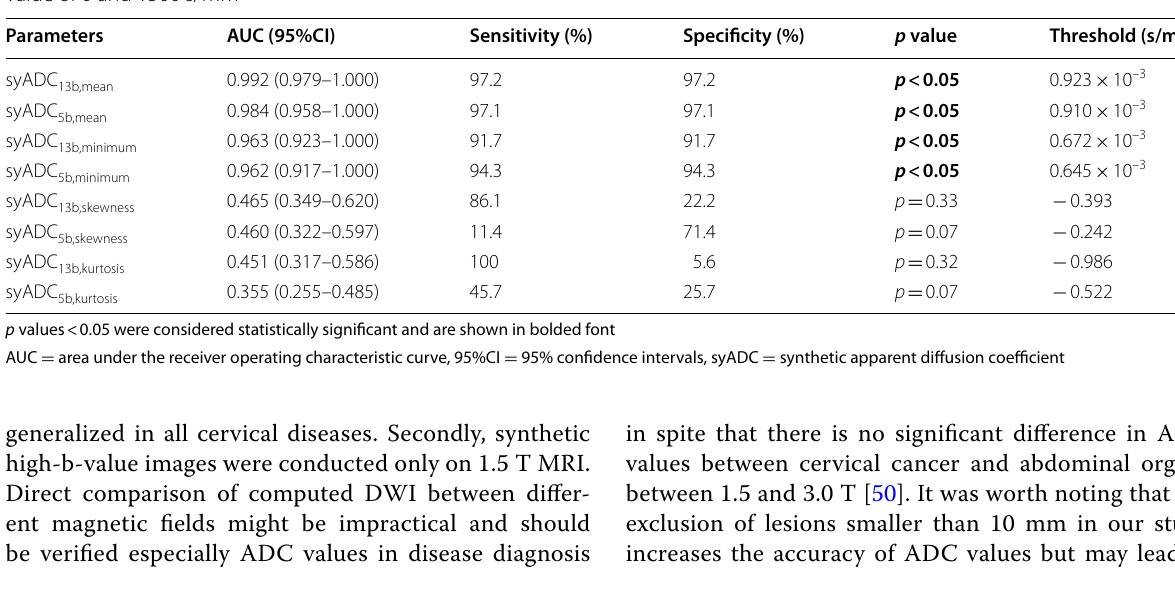
Table 6 Diagnosis performance on cervical cancer of histogram-derived synthetic 13b-protocol and 5b-protocol ADC values with a b value of 0 and 1500 s/mm